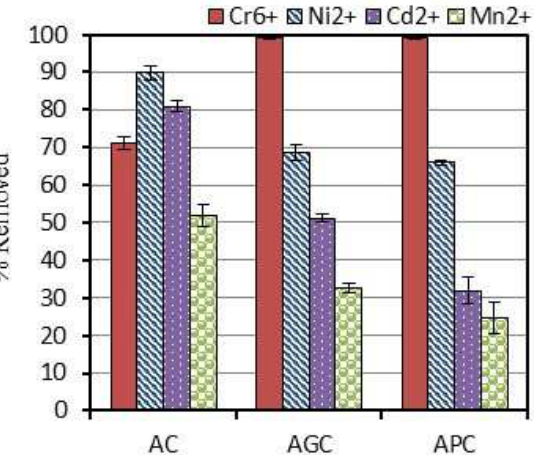
Figure 3. Percent removal of metal ions on different adsorbents (500 mg).